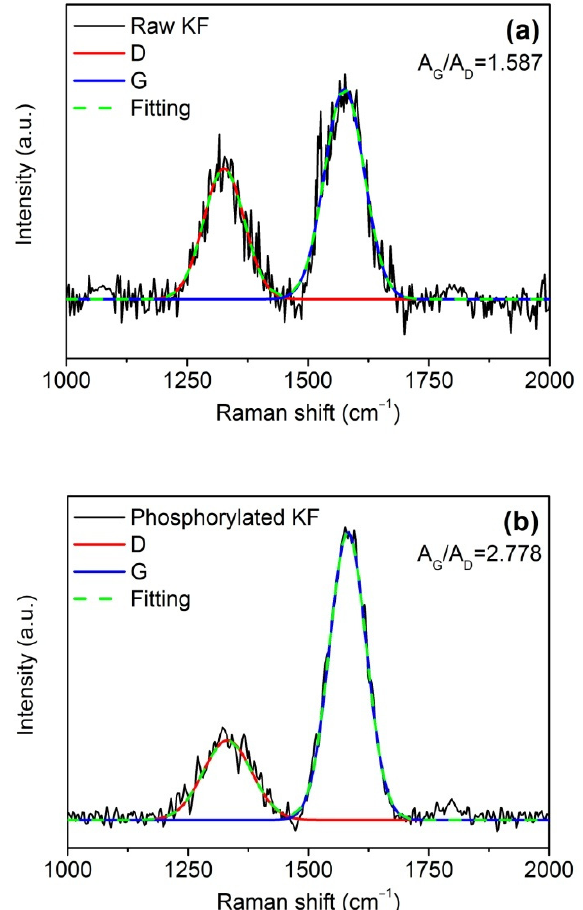
Figure 11. Ramanspectra of the residual char of raw KF ( a ) and phosphorylated KF ( b ) after combustion; phosphorylated KF sample was obtained using 6 g PA.